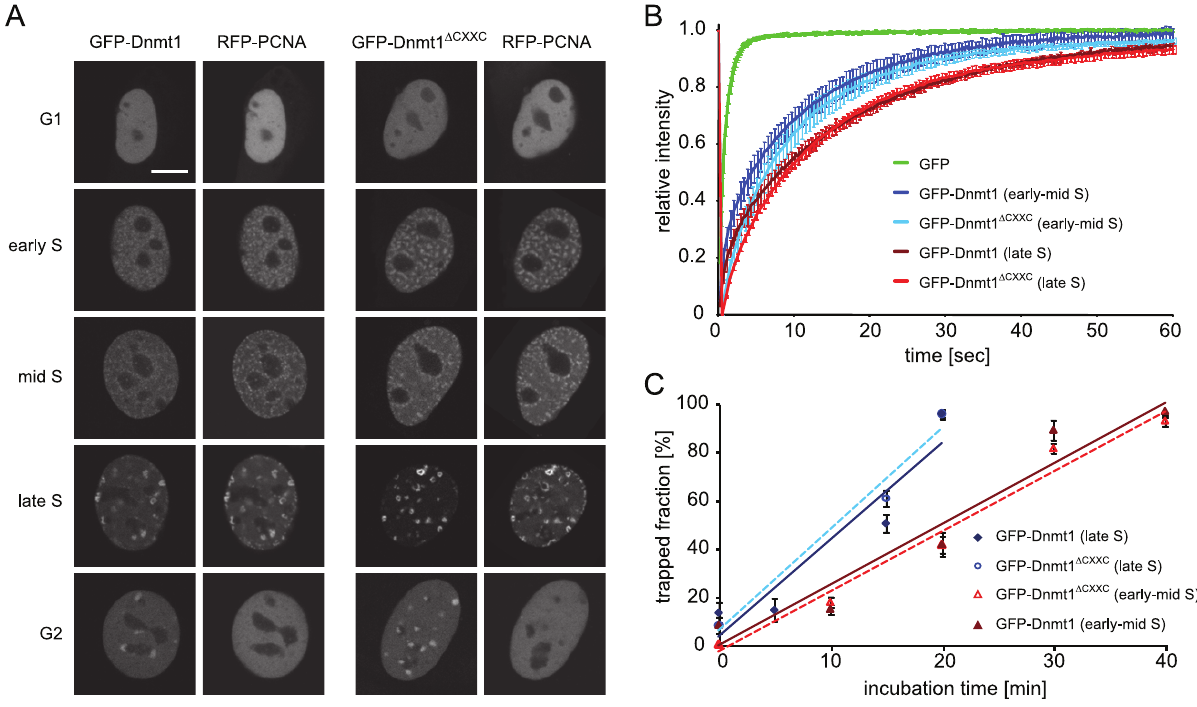
Figure 5. Cell cycle dependant cellular localization, protein mobility and trapping of wild-type Dnmt1 and CXXC deletion constructs in mouse C2C12 myoblasts. ( A ) Cell cycle dependent localization of GFP-Dnmt1 and GFP-Dnmt1 D CXXC constructs. Scale bar: 5 m m. ( B ) Analysis of binding kinetics of GFP-Dnmt1 and GFP-Dnmt1 D CXXC in early and late S-phase cells by FRAP. The recovery curve for GFP is shown for comparison. ( C ) In vivo trapping by FRAP analysis in cells treated with 5-aza-dC. The trapped enzyme fraction is plotted over time for early and late S- phase cells. For each construct three to six cells in early-mid and late S phase were analysed per time point. Shown are mean values 6 SEM. In (A–C) RFP-PCNA was cotransfected to identify cell cycle stages in living